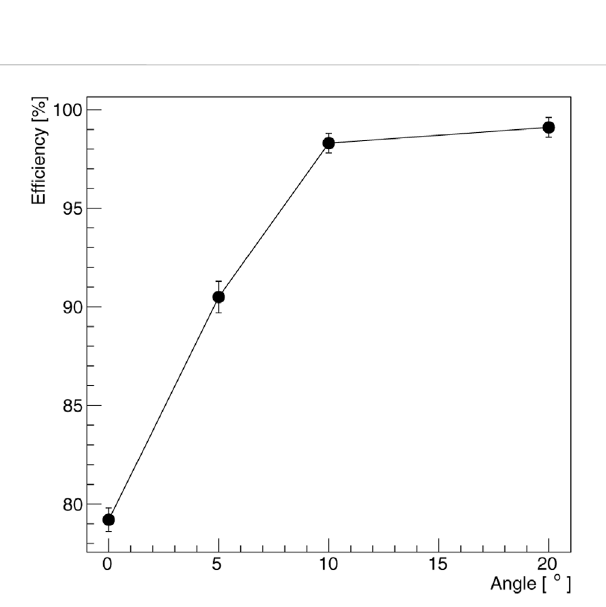
FIGURE 7 Triple strip ef fi ciency calculated by counting the yield of signal events from a fi t to the time distribution (blue) and from the number of events with the amplitude above a given threshold (red). Note that for this comparison the ef fi ciencies are not corrected for the fraction f miss .